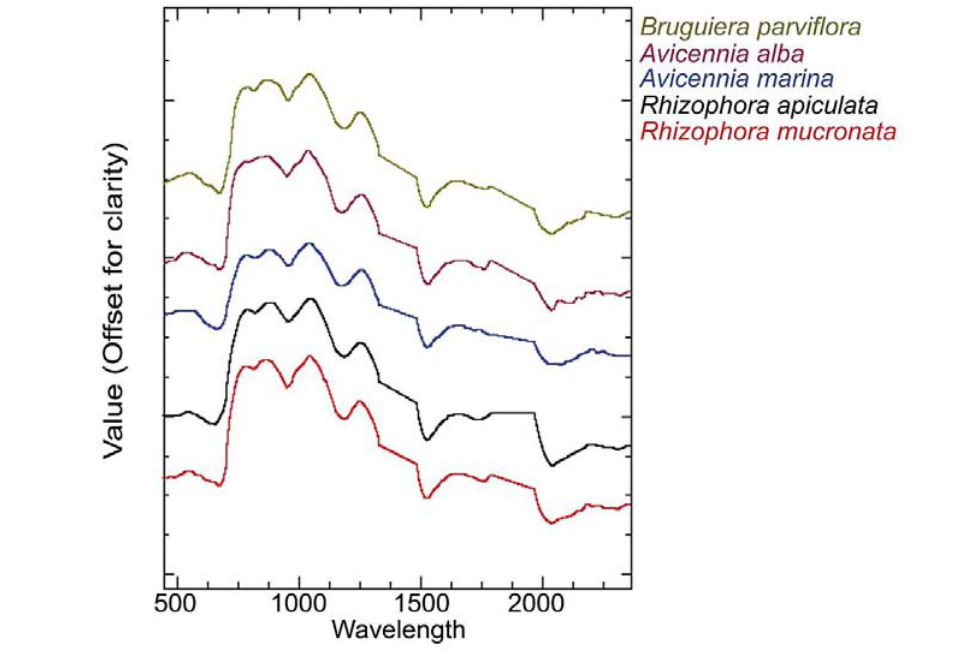
Figure 2. The stack plot of average reflectance curves of five tropical mangrove species under study.